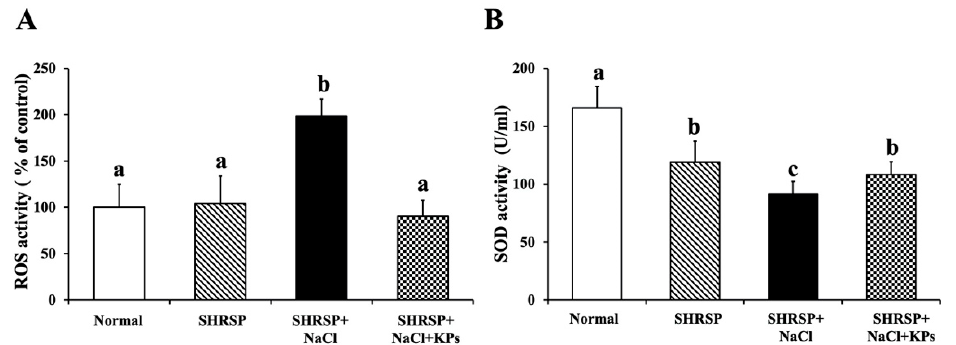
Figure 5. KPs treatment reduced the oxidative stress and increased the SOD activity in the kidneys of salt-sensitive SHRSP rats. ( A ) SHRSP rats in the SHRSP + NaCl group showed significantly increased kidney ROS accumulation. However, the treatment of salt-induced SHRSP rats with KPs reduced the ROS content to the level of that observed in the control WKY rats. ( B ) SHRSP rats in the SHRSP + NaCl group showed a significantly reduced SOD activity, but this activity was restored in the SHRSP + NaCl + KPs group due to the KPs administration. Data are presented as the means ± SEMs (Normal, n = 5; SHRSP, n = 5; SHRSP + NaCl, n = 6; SHRSP + NaCl + KPs, n = 6) and were analyzed by one-way ANOVA. Data within columns that are not labeled with the same letter are significantly different ( p < 0.05), as determined using Duncan’s test.